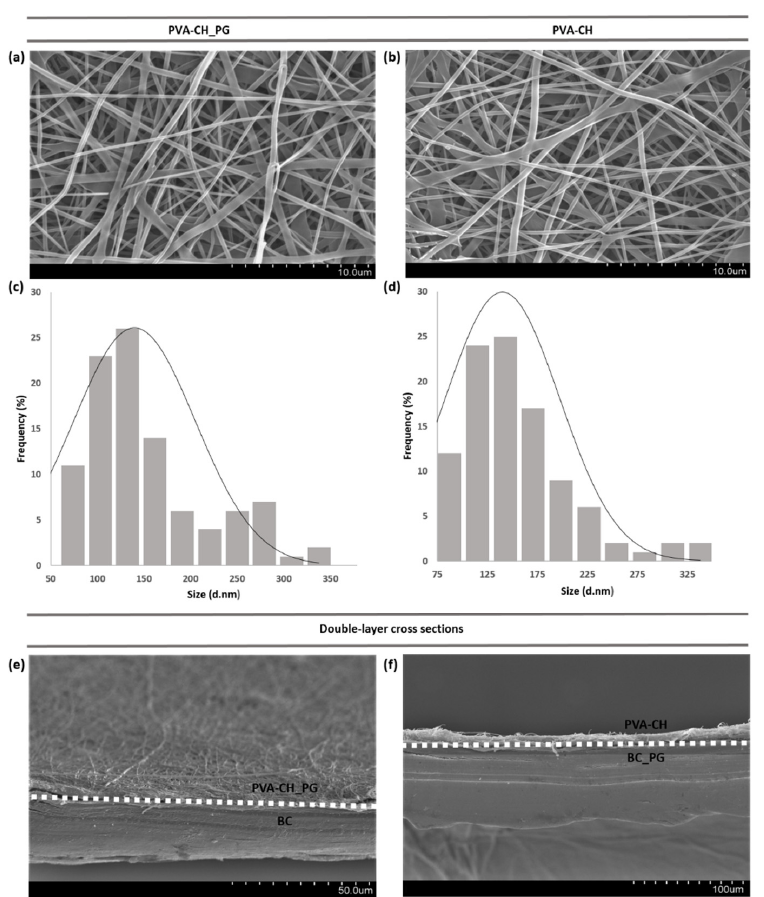
Figure 2. SEM images of PVA-CH_PG coating layer ( a ) and PVA-CH without PG pigment ( b ); fiber diameter distributions of PVA-CH_PG ( c ) and PVA-CH ( d ); cross-section of the composite materials produced, with a perspective emphasizing the layer containing the PG pigment: BC/PVA-CH_PG ( e ) and BC_PG/PVA-CH ( f ).